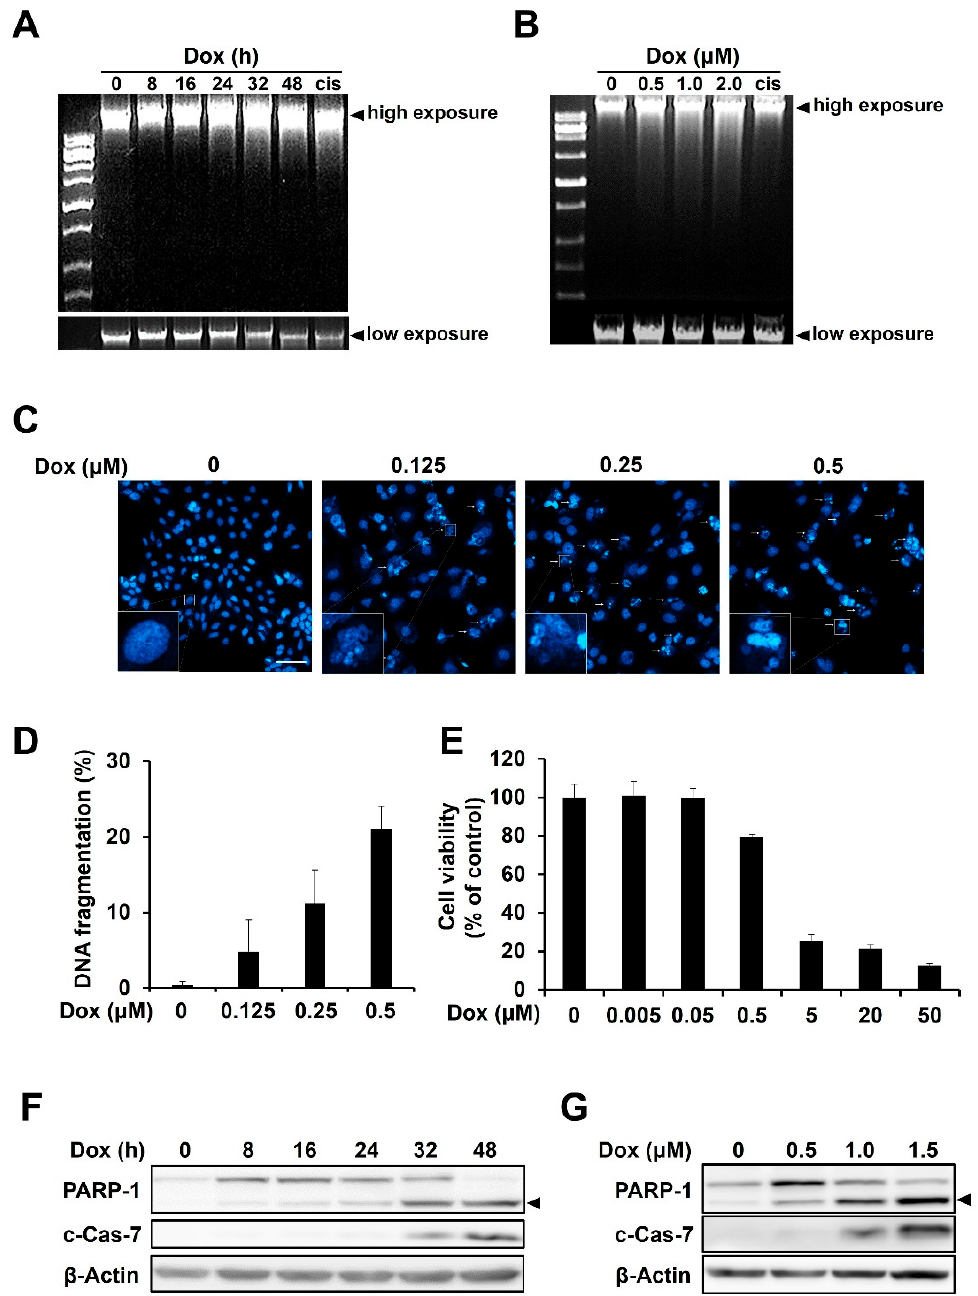
Figure 1. Doxorubicin induces DNA damage and apoptosis in HCC1143 triple-negative breast cancer cells. ( A , B ) Cells were treated with doxorubicin for the indicated time period or dose. DNA was extracted from cells and electrophoresed on agarose gels. Cisplatin (cis) was used as a positive control. ( C , D ) Cells were treated with the indicated concentrations of doxorubicin for 48 h and stained with Hoechst 33342, at room temperature, for 10 min. Nuclear morphological changes were observed